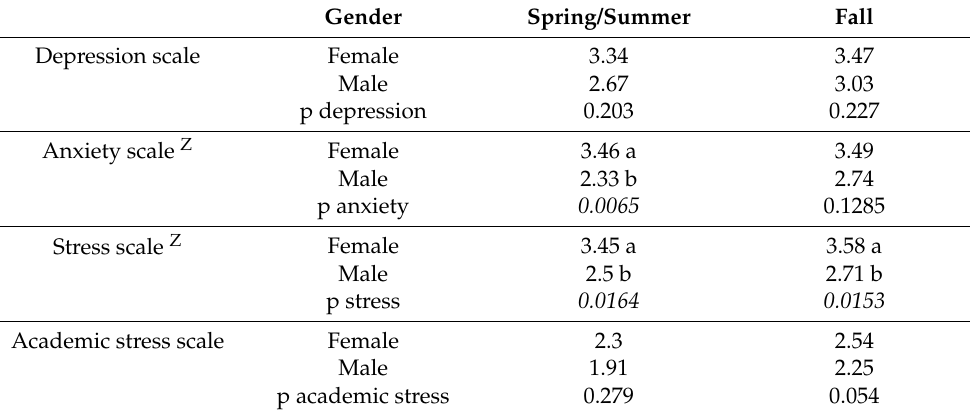
Table 3. Effects of DASA scores on gender.